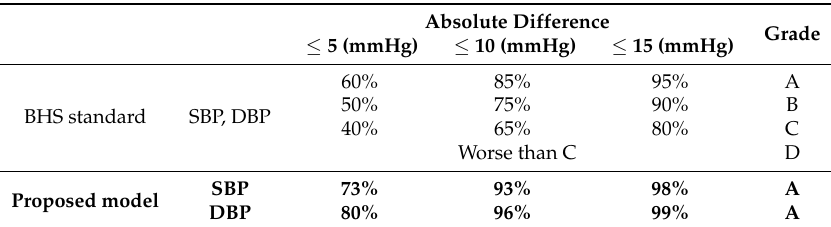
Table 9. Performance comparison with the BHS